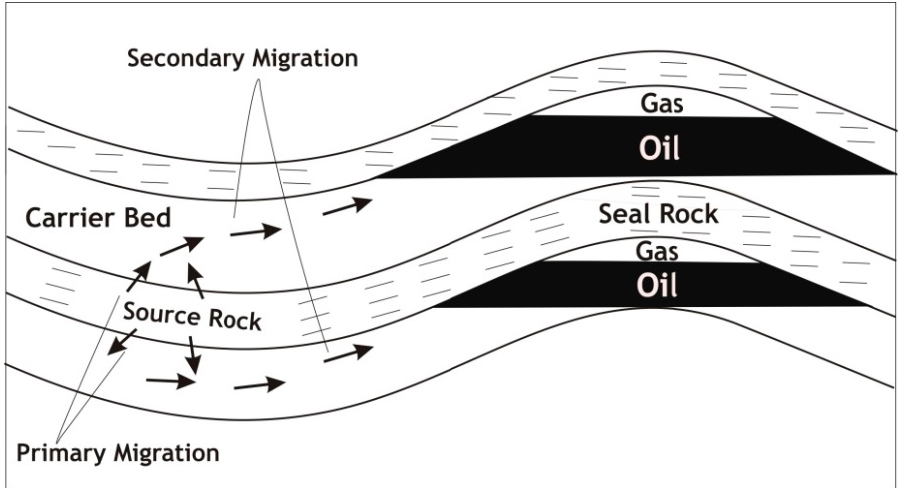
Figure 1. Secondary petroleum migration from source rock to stratigraphic trap.